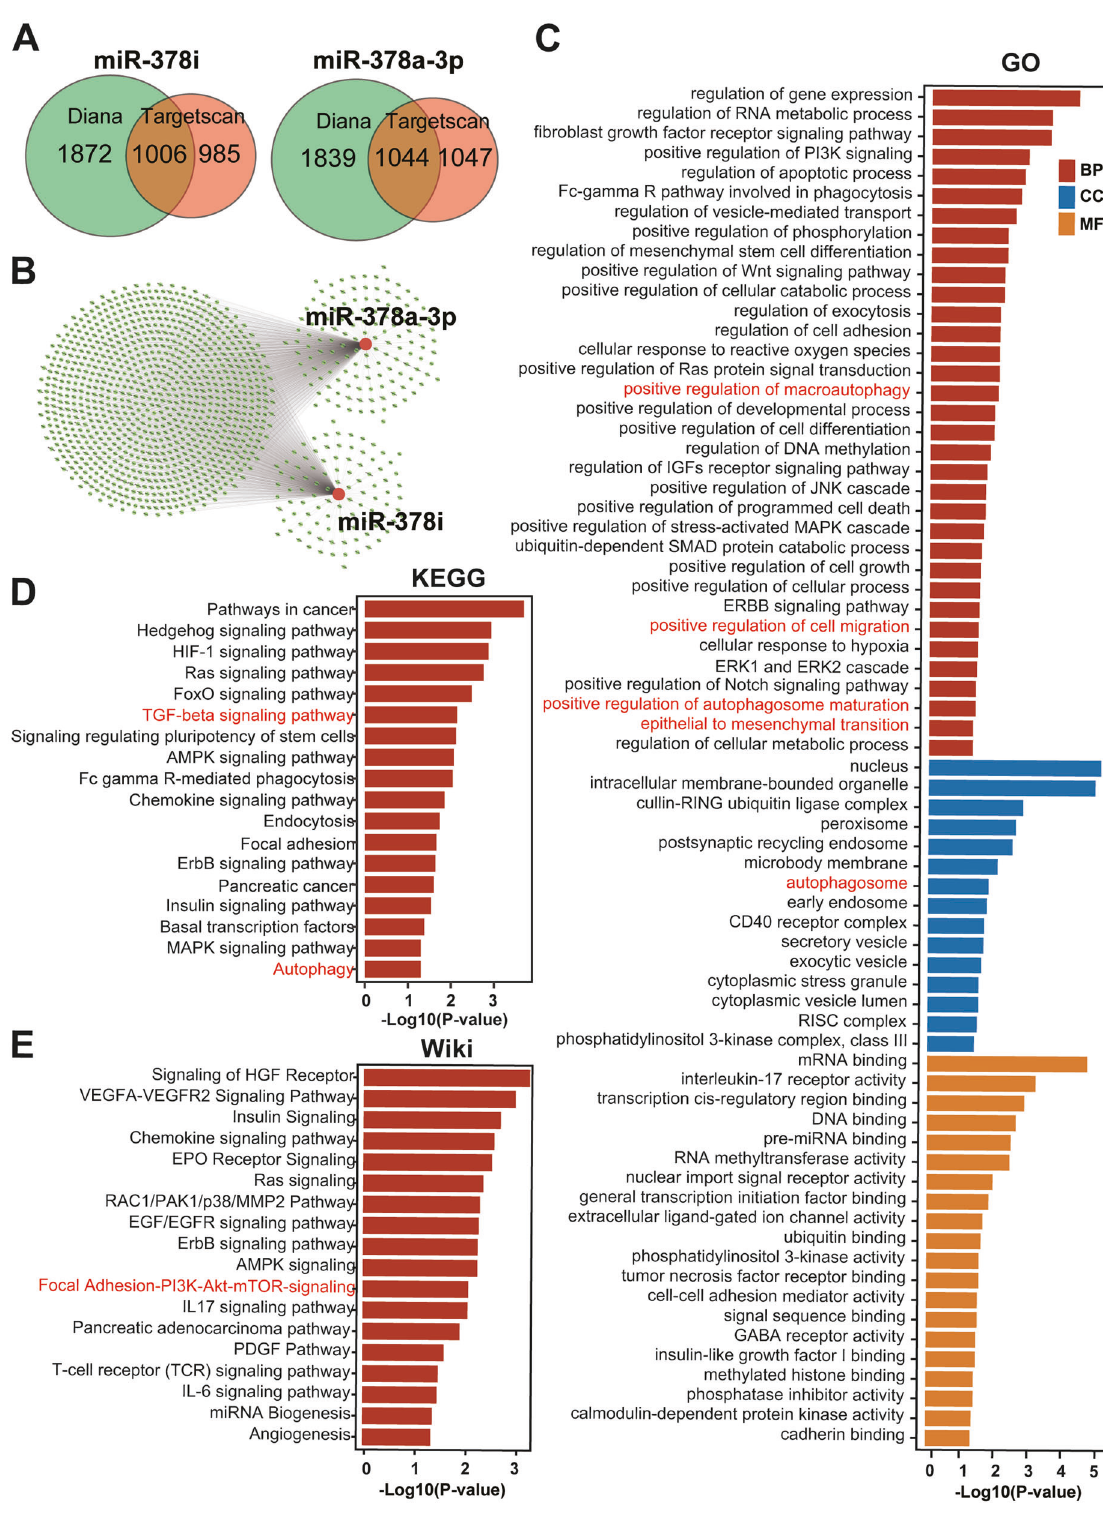
Fig. 8 Detection of miR-378 target genes and related autophagy and cancer progression signaling via bioinformatics analysis. A Target genes of miR-378i and miR-378a-3p were predicted using the TargetScan (green) and DIANA-microT (red) databases and are shown as Venn plots. B The identi fi ed target genes were organized into a gene regulatory network using Cytoscape. Red circles: miR-378a-3p and miR-378i; red lines represent the connection of the speci fi c miR to its corresponding target genes. To further highlight associations between miR-378i and miR-378a-3p target genes and signaling chains, the comprehensive gene set enrichment analysis web server Enrichr (https:// maayanlab.cloud/Enrichr/enrich) was used to analyze gene sets in different databases. C Gene Ontology (GO) enrichment analysis was performed. BP biological process, CC cellular component, MF molecular function. D Likewise, Kyoto Encyclopedia of Genes and Genomes (KEGG) pathway analysis was conducted. E The WikiPathways database of biological pathways was screened.